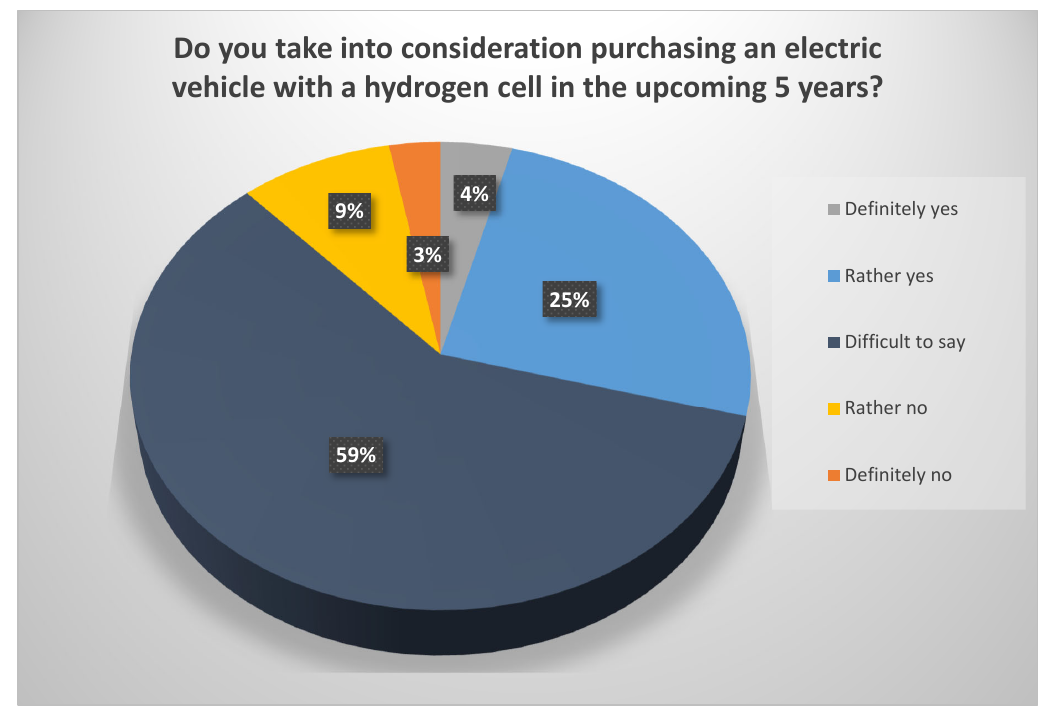
Figure 5. Survey question number 5. Source: own study.